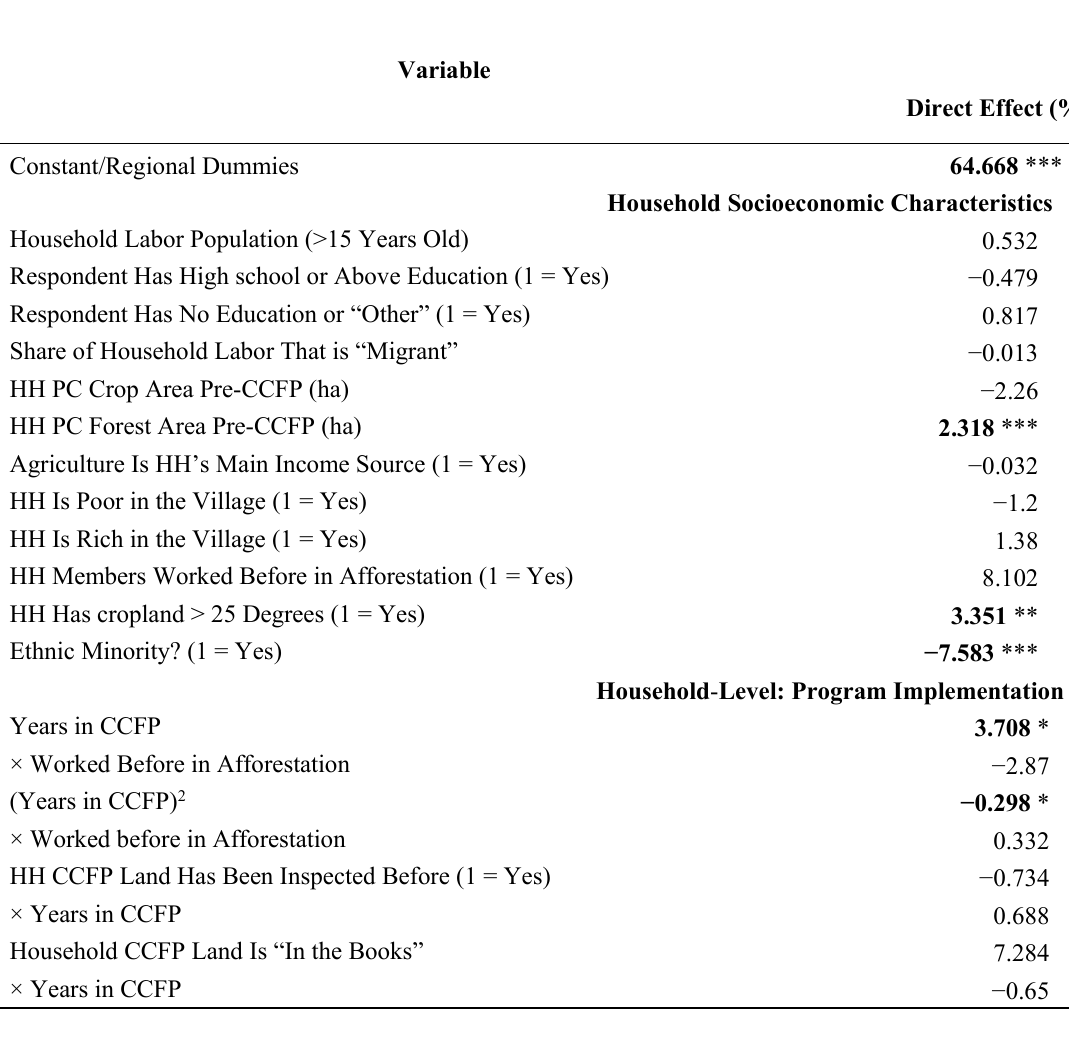
Table 5. Interval regression model of tree survivorship on household conversion of cropland to forests program (CCFP) enrolled land with regional